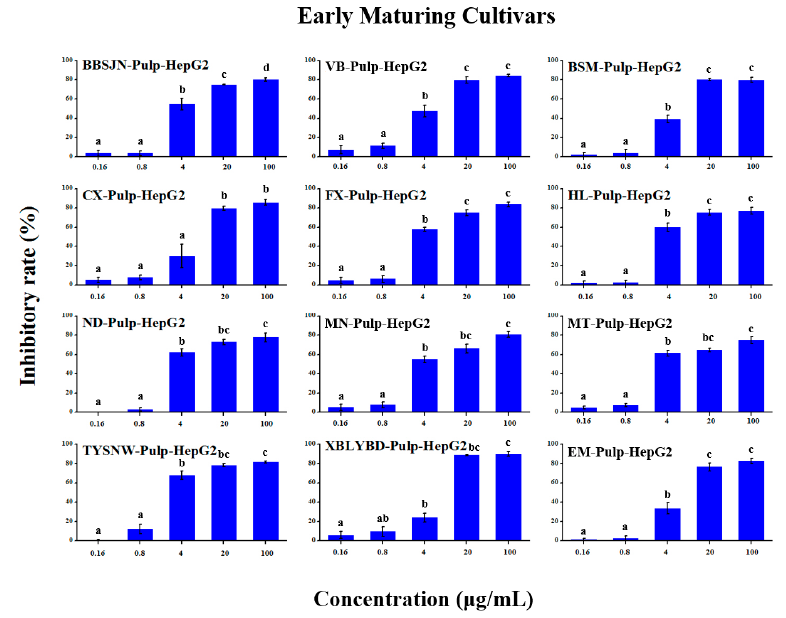
Figure 6. HepG2 growth inhibition e ff ect of pulp extracts from early maturing cultivars.The names of apple cultivars were showed as abbreviations: VB for ‘Vista Bella’, MT for ‘Mato’, EM for ‘Early McIntosh’, TYSYW for ‘Tianyisayewa’, CX for ‘Chunxiang’, FX for ‘Faxian’, MN for ‘Matsumoto Nishiki’, BBSJN for ‘Babusijinuo’, XBLYBD for ‘Xiboliyabaidian’, BSM for ‘Basimei’, HL for ‘Honglu’, ND for ‘Nuoda’. Di ff erent lowercase letters above the bars indicated significant di ff erences at the 0.05 probability level by Tukey test.